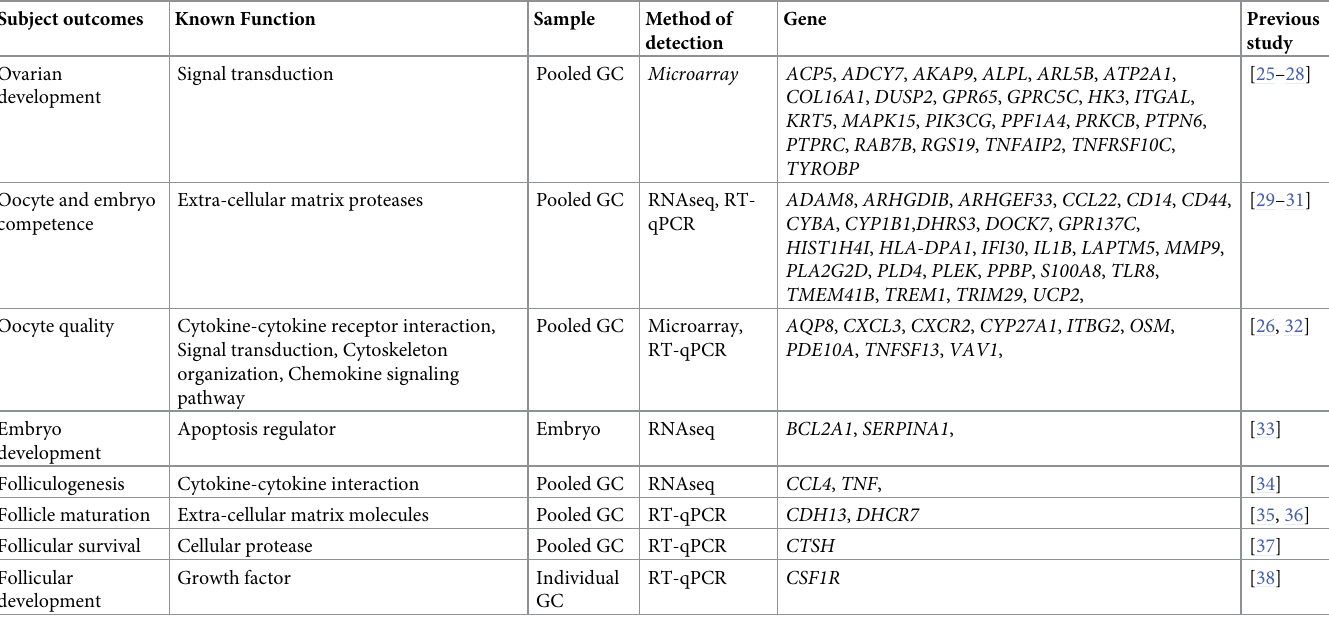
Table 4. Candidate genes associated with embryo